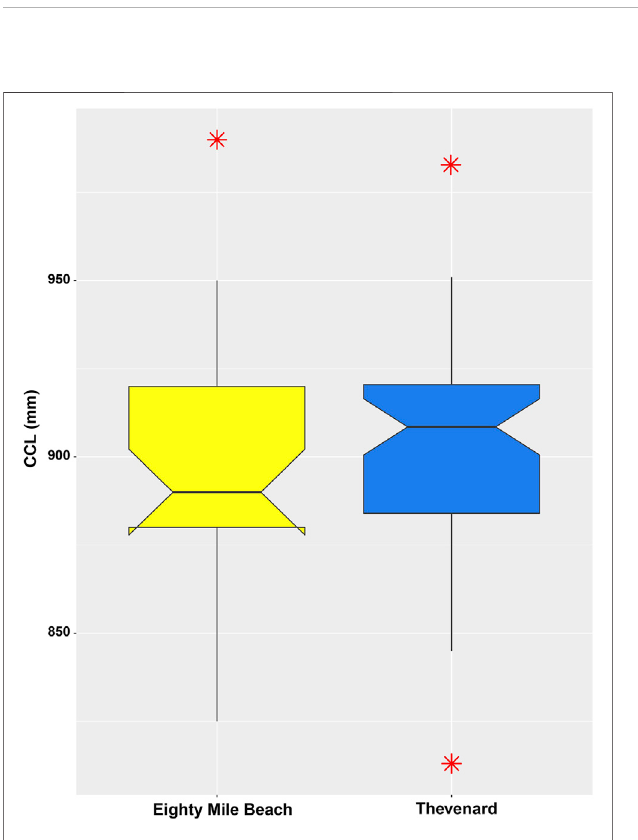
FIGURE2| BoxplotshowingCCL(mm)ofturtlesfromEightyMileBeach (control site) and Thevenard Island (impact site), WA. Bar whiskers show the 10th and 90th percentiles, box shows the 25th and 75th percentiles and the solidlineintheboxshowsthemedianmetalconcentrationsforeachsite. The asterisks indicate values that exceed the 1.5 interquartile range.